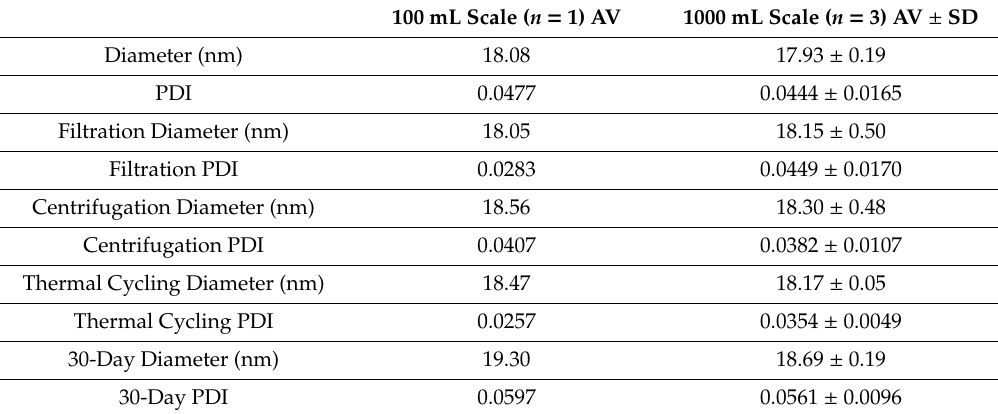
Table 11. Summary of CQA specification testing for scaled up (1000 mL)